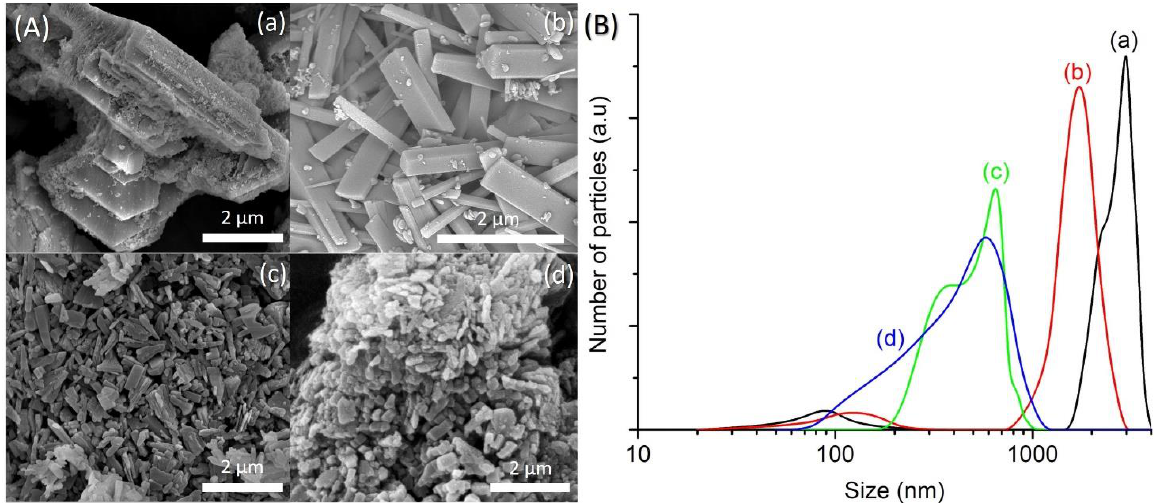
Figure 6. ( A ) FESEM images and ( B ) particle size distributions of ( a ) SH9 ( x = 1.5), ( b ) SH10 ( x = 2.0), ( c ) SH4 ( x = 2.5) and ( d ) SH11 ( x = 3.0) where the solid products were prepared using precursor hydrogels with a molar composition of